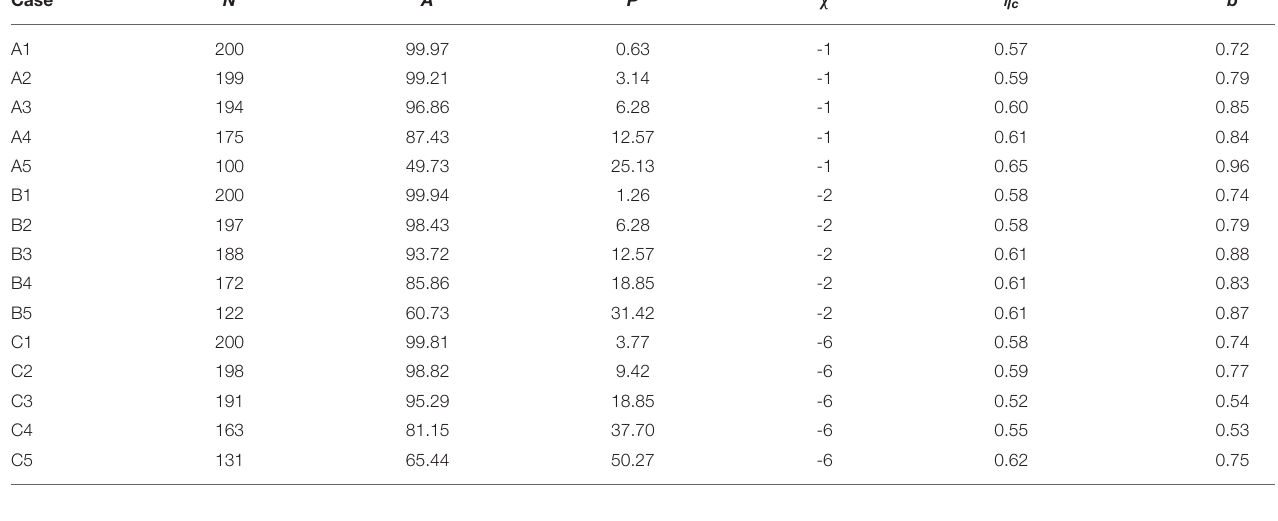
TABLE 2 | Geometric measures of the domain structure with fitted critical noise amplitude η c and scaling exponent b . Case